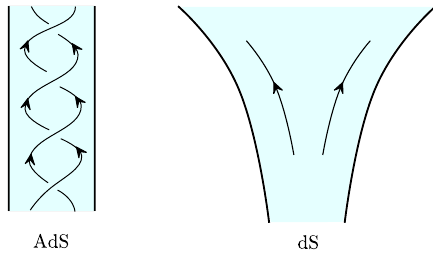
Figure 11 . Two-particle states in AdS and dS. In AdS, the double-trace operators correspond to states in which two particles are orbiting each other. This is possible thanks to the gravitational potential in AdS. In dS, such states cannot exist as stable states and become resonances, owing to the expansion of dS.